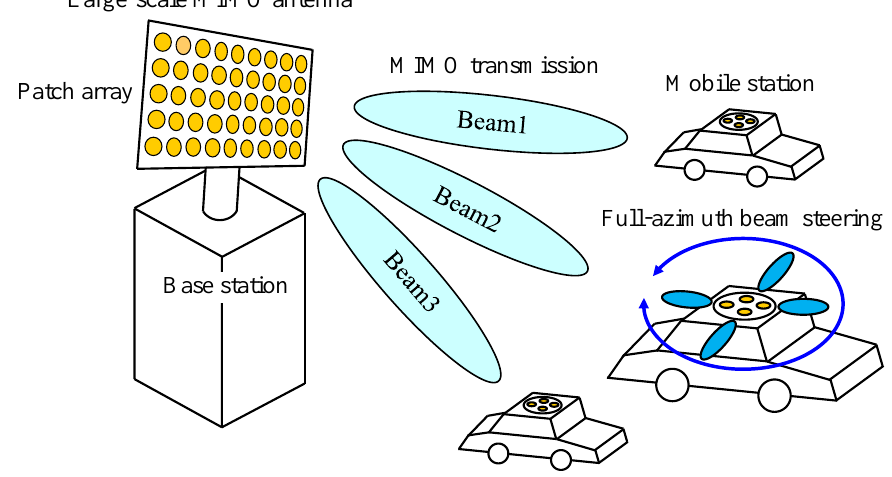
Figure 1. Conceptual illustration of a massive MIMO system.